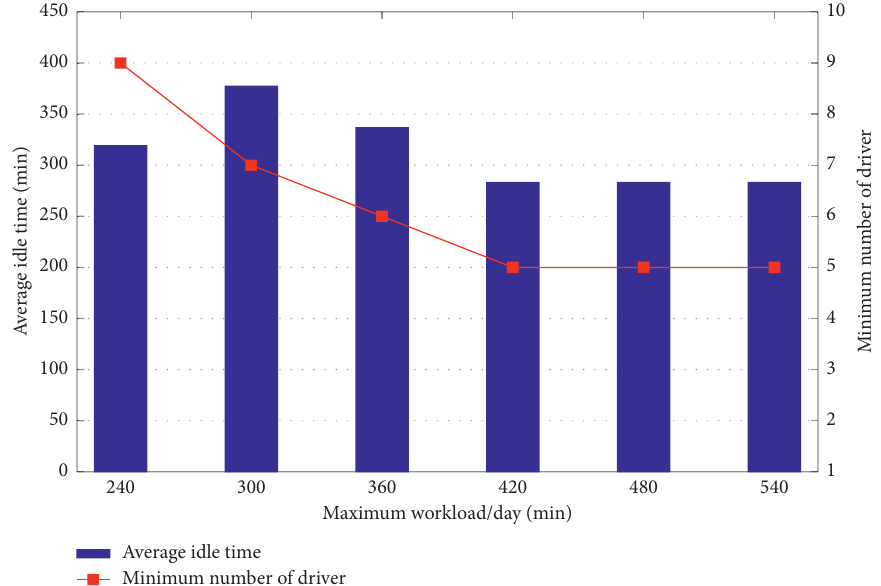
Figure 8: Minimum number of drivers and average idle time under different